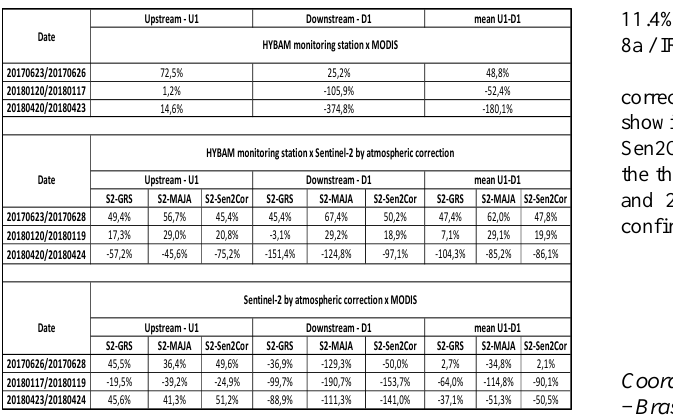
Table 4 – Difference between estimated suspended sediment concentrations and HYBAM measurements